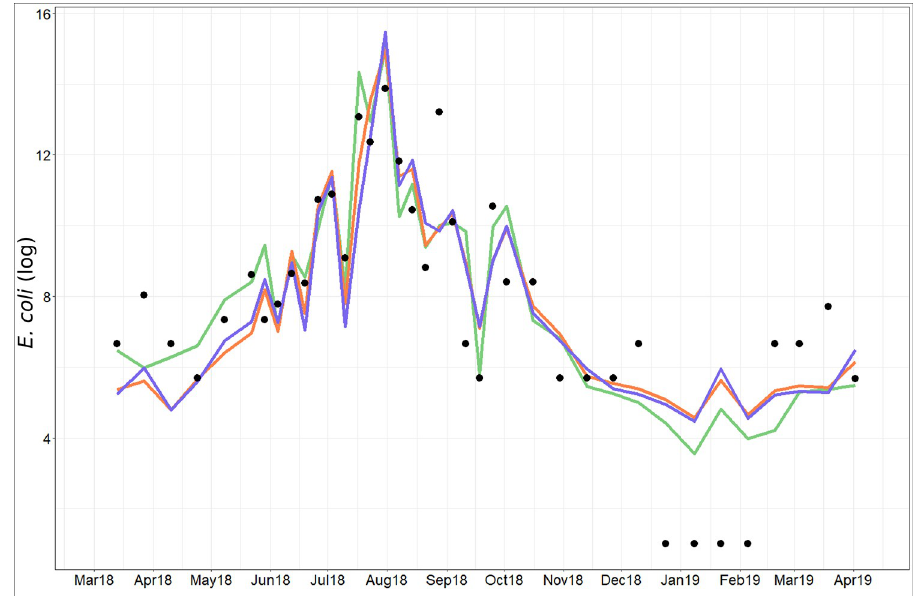
Fig 9. Observed E . coli (black point) and predicted E . coli (green line for all variables, orange line for NIR band, SPM and Rainfall variables, blue line for satellite